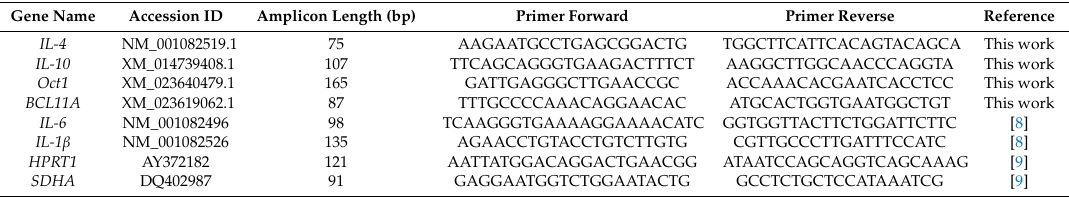
Table 2. Genes evaluated in this study: Interleukin-4 ( IL-4 ), Interleukin-6 ( IL-6 ), Interleukin-10 ( IL-10 ), 11A ( BCL11A ) Hypoxanthine-guanine phosphoribosyltransferase, ( HPRT ), Succinate